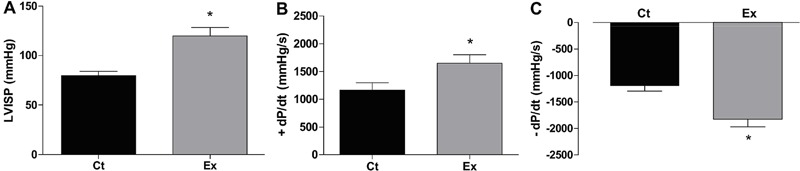
Contractility values from isolated heart. A, left
ventricular isovolumetric systolic pressure (LVISP); B,
positive first time derivative (+dP/dt), and C, negative first
time derivative (−dP/dt) from control (Ct, n=6) and exercised (Ex, n=6)
spontaneously hypertensive rats (SHR) under control conditions in Langendorff
apparatus. Results are reported as means±SE. *P<0.05, compared to Ct
(Student’s t-test).